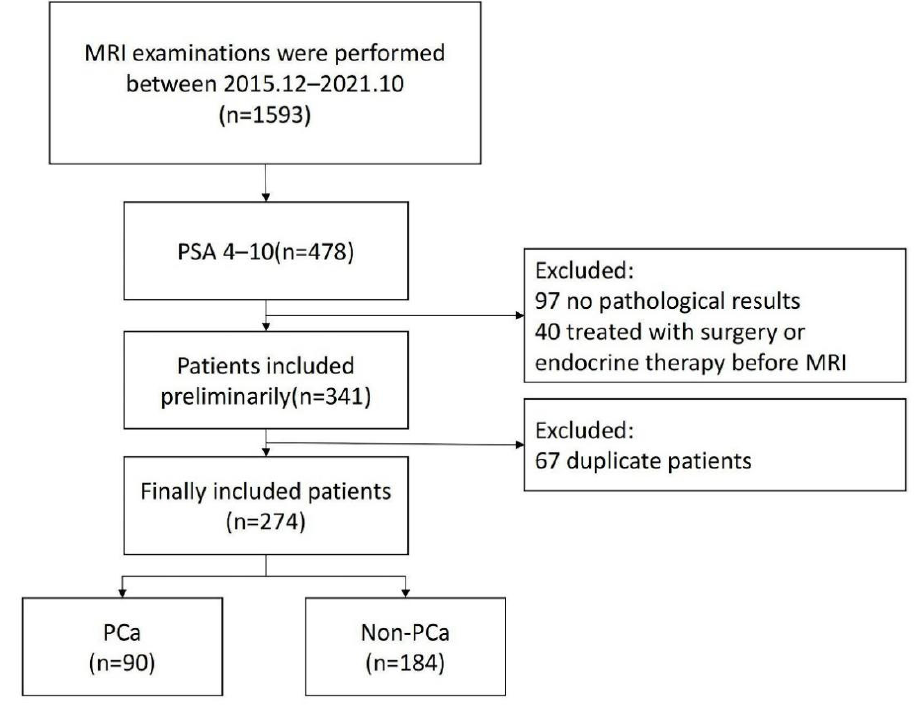
Figure 1. Patient selection flowchart.